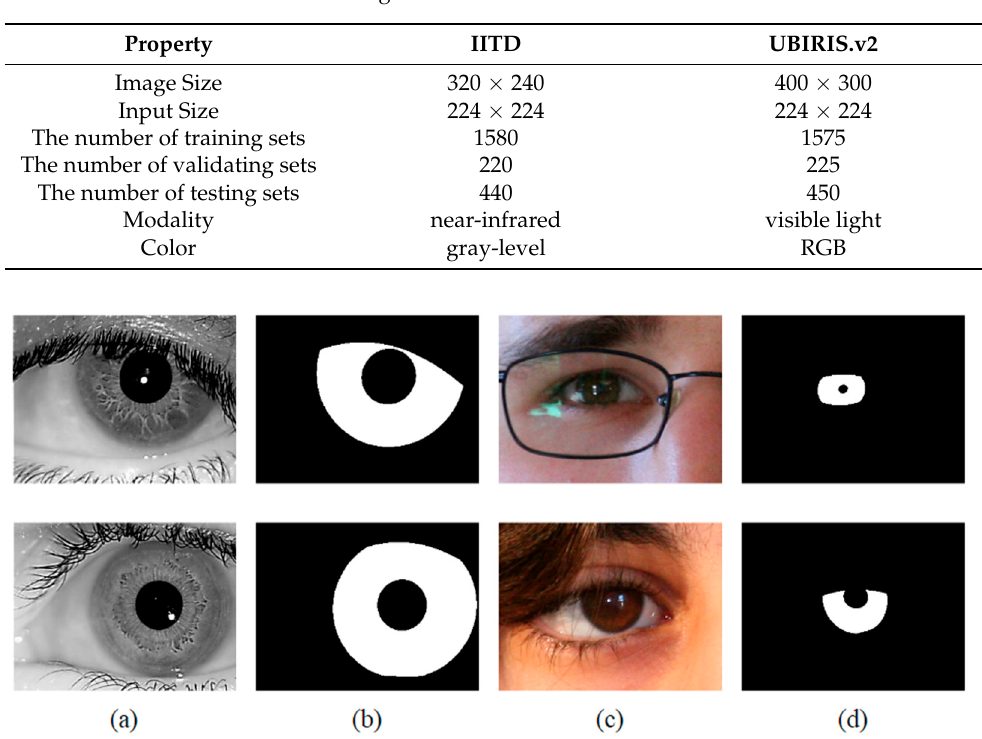
Table 2. The characteristics of iris image databases.